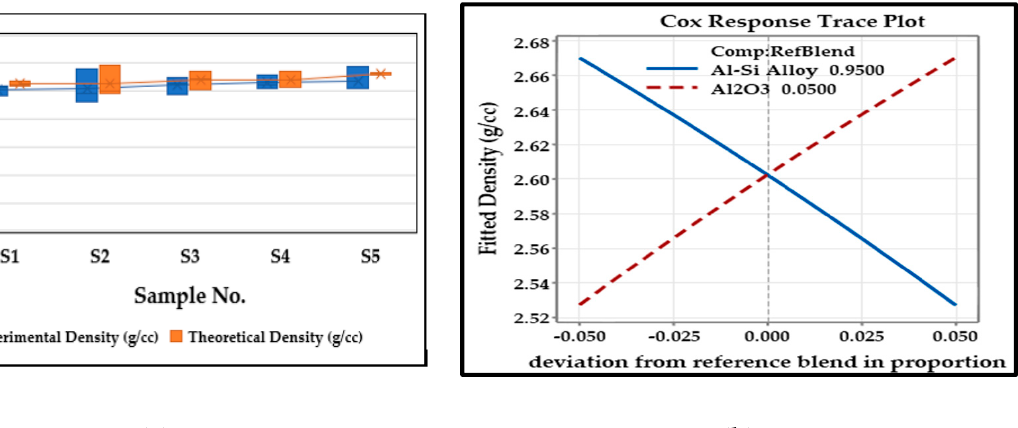
Figure 3. Variation of Density due to the reinforcing particles and Cox trace plot. ( a ) Density; ( b ) Cox Response Trace.